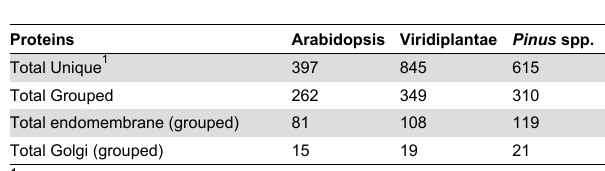
Table 2. Activity of the GalS marker enzyme in pine homogenates and sucrose gradient interfaces.